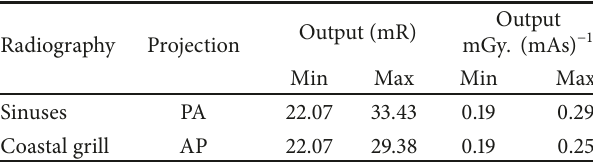
Table 2: Output of X-ray tube in mR and mGy . ( mAs ) −1